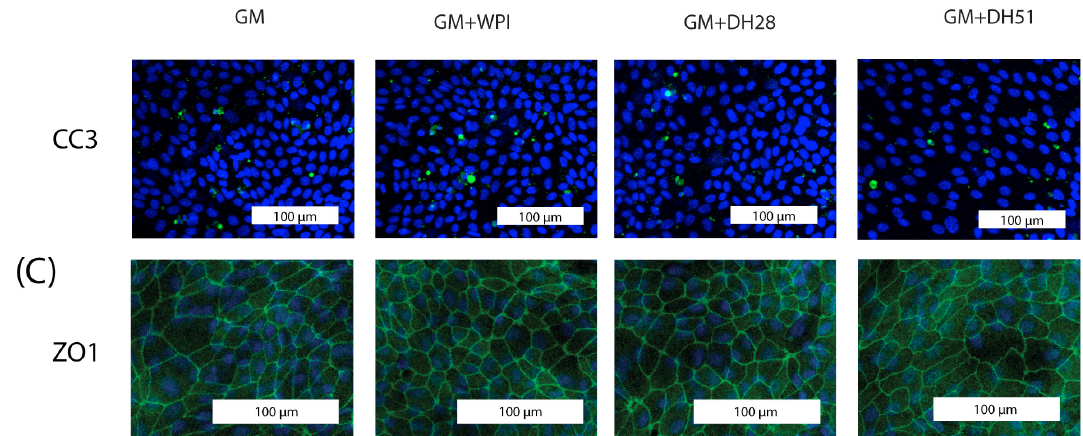
Figure 7. Effect of WPI, DH28 and DH51 on villus-like HIO (monolayer-cultured) in a healthy setting (normoxia). ( A ) mRNA expression of IL8 (pro-inflammatory cytokine), OLFM4 (stem cells), LYZ (Paneth cells), PEPT1 (di/tri-peptide transporter) and LAT2 (amino acid transporter) in villus-like HIO monolayers following 24 h exposure to WPI, DH28, or DH51 compared to control. Data are reported as relative expression compared to control (set at 1) and displayed as median with interquartile range. Results were obtained from 3 different HIO donors (depicted by different data point symbols, one symbol type per donor). * p ≤ 0.05 ( B ) Analysis of the % of surface area positive for CC3 and representative images from immunofluorescence staining of CC3 in villus-like HIO monolayers exposed to WPI, DH28 or DH51 for 24 h compared to controls. Data are displayed as median with interquartile range. Results were obtained from 3 different HIO donors (depicted by different data point symbols, one symbol type per donor). Scale bars indicate 100 μ m. ( C ) Representative images from immunofluorescence staining of ZO1 in villus-like HIO monolayers exposed to WPI, DH28, or DH51 for 24 h compared to controls. Results were obtained from 3 different HIO donors. Scale bars indicate 100 μ m. Abbreviations: IL8—interleukin 8; OLFM4—olfactomedin 4;